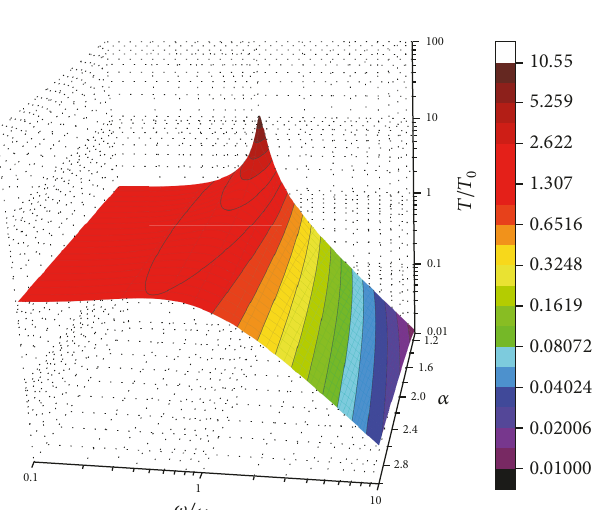
Figure 46: Transmissibility surface ( 𝛽 = 1 ).